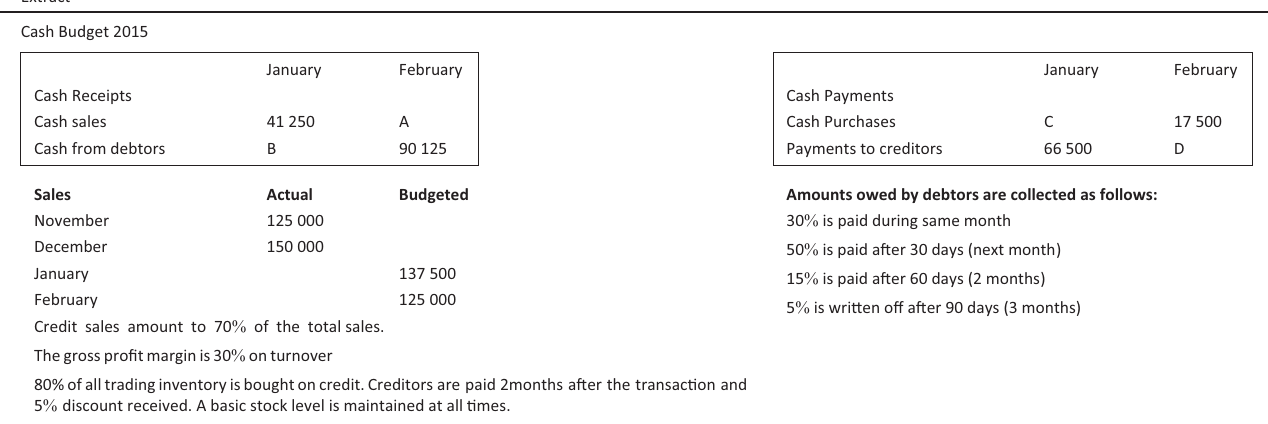
FIGURE 27: Consider the following example from second-year accounting.